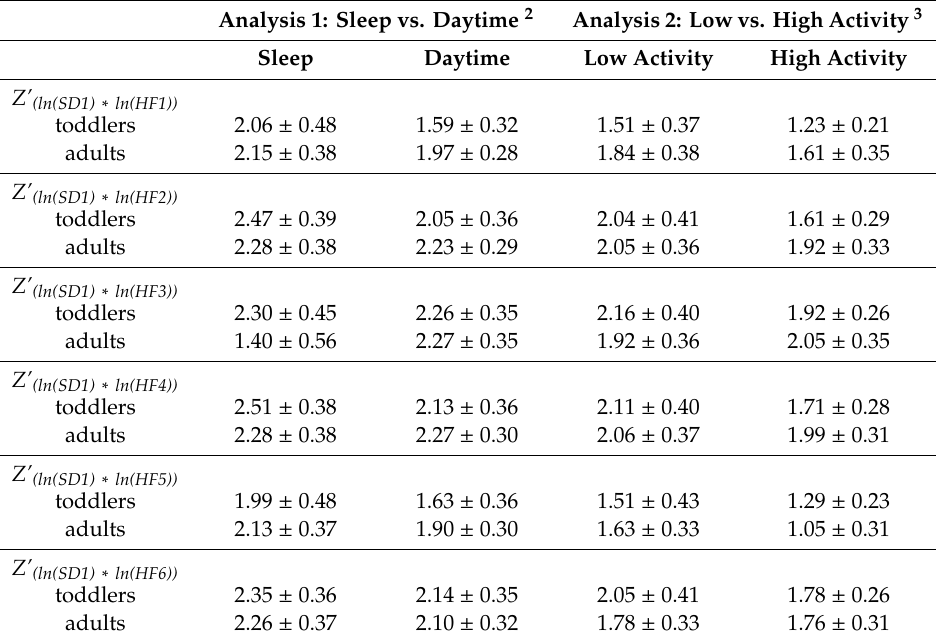
Table 1. Mean correlation coe ffi cients (Fisher’s Z’) between SD 1 and absolute band power in the six HF bands 1 (mean ±